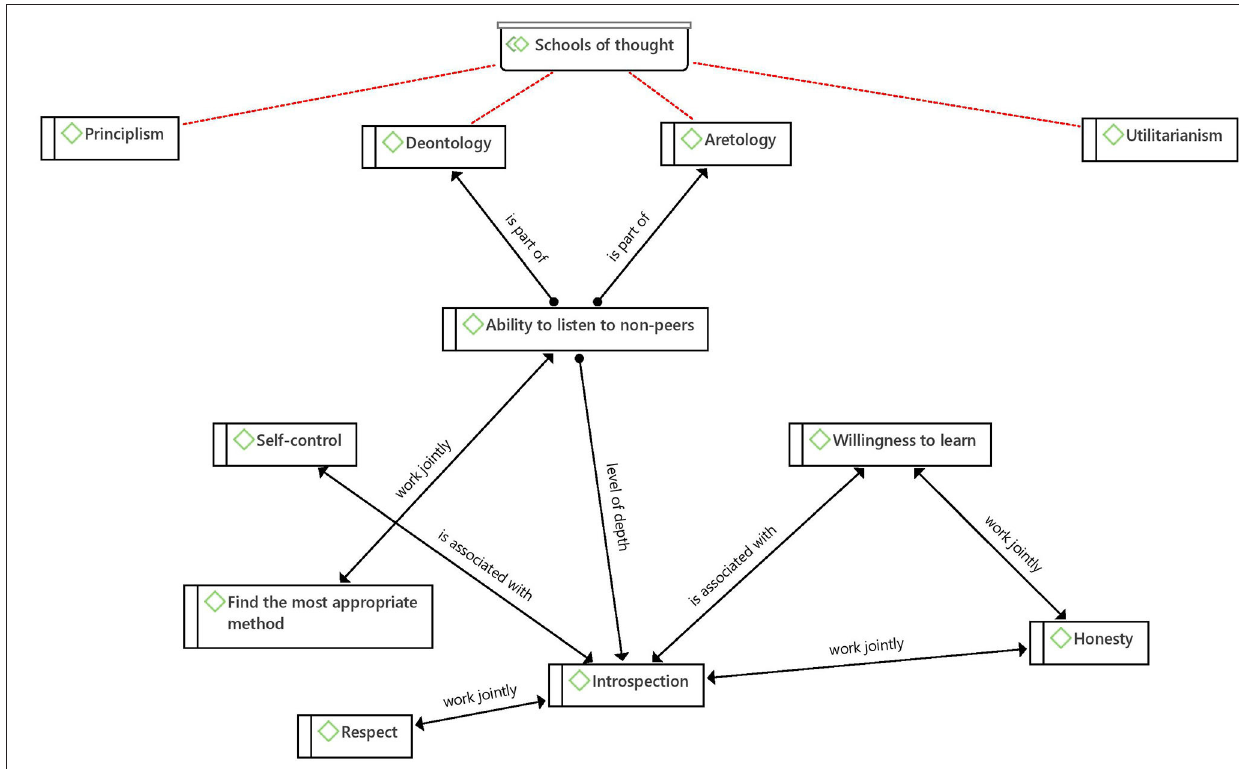
FIGURE 7 | Net between ethical schools of thought.